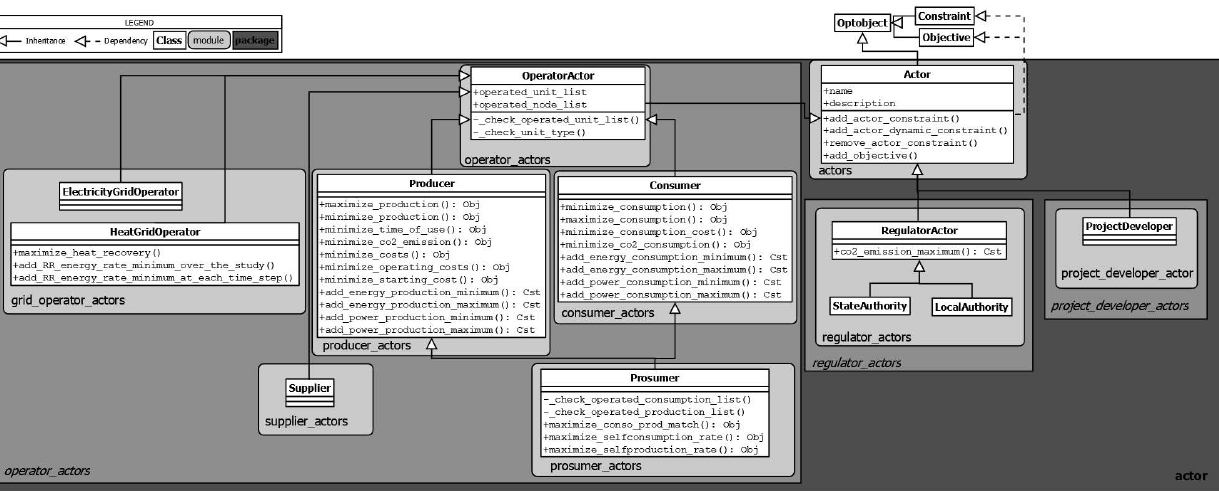
Figure A2. Actor package UML